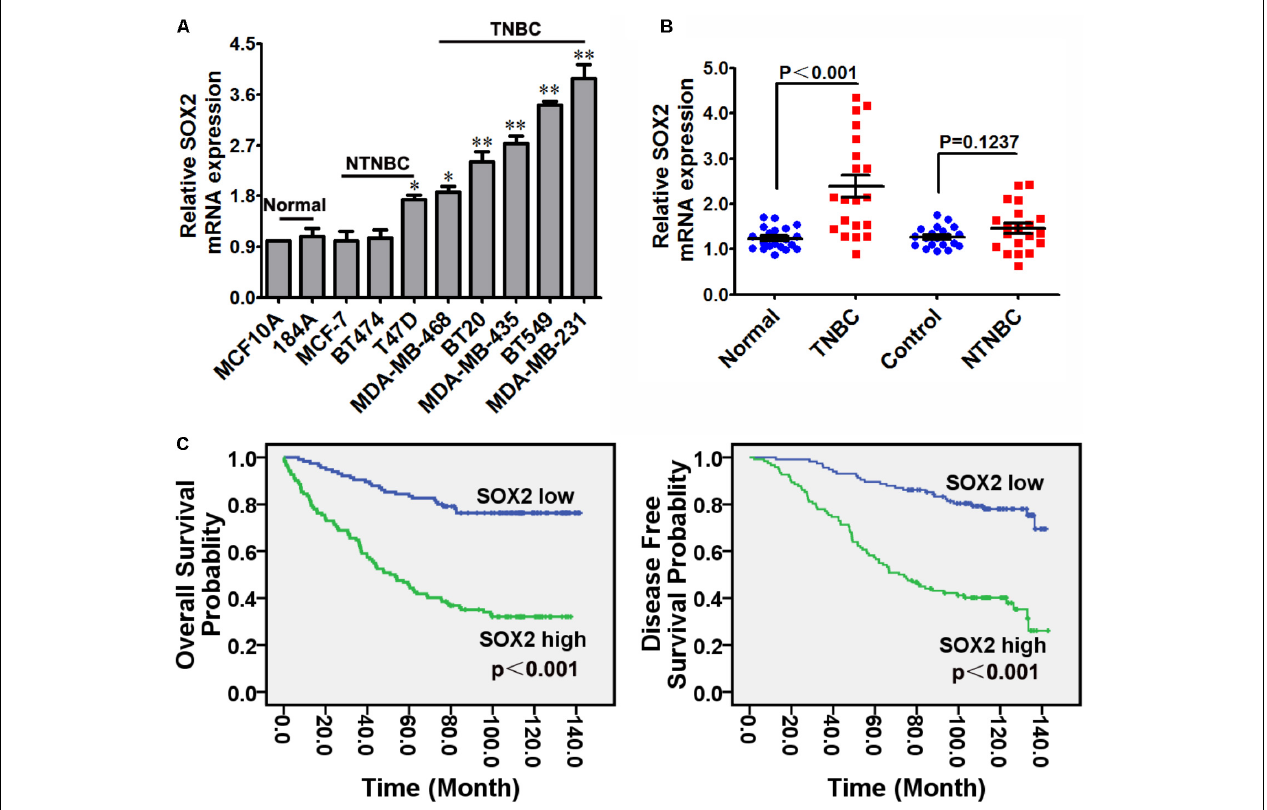
FIGURE 1 | SOX2 overexpressed in TNBC cells and tissues, and correlated with poor clinical outcomes in TNBC. (A) Expression of SOX2 in 4 TNBC cell lines, 4 NTNBC cell lines and 2 mammary normal cell lines detected by qRT-PCR. β -actin was used as an internal control ( ∗ p < 0.05, ∗∗ p < 0.01). (B) Expression of SOX2 in 20 TNBC tissues and their corresponding paired normal adjacent tissues (Normal), 20 NTNBC tissues and their corresponding paired normal adjacent tissues (Control). (C) OS and DFS curves for 237 cases of TNBC patients with high or low level of SOX2 expression.